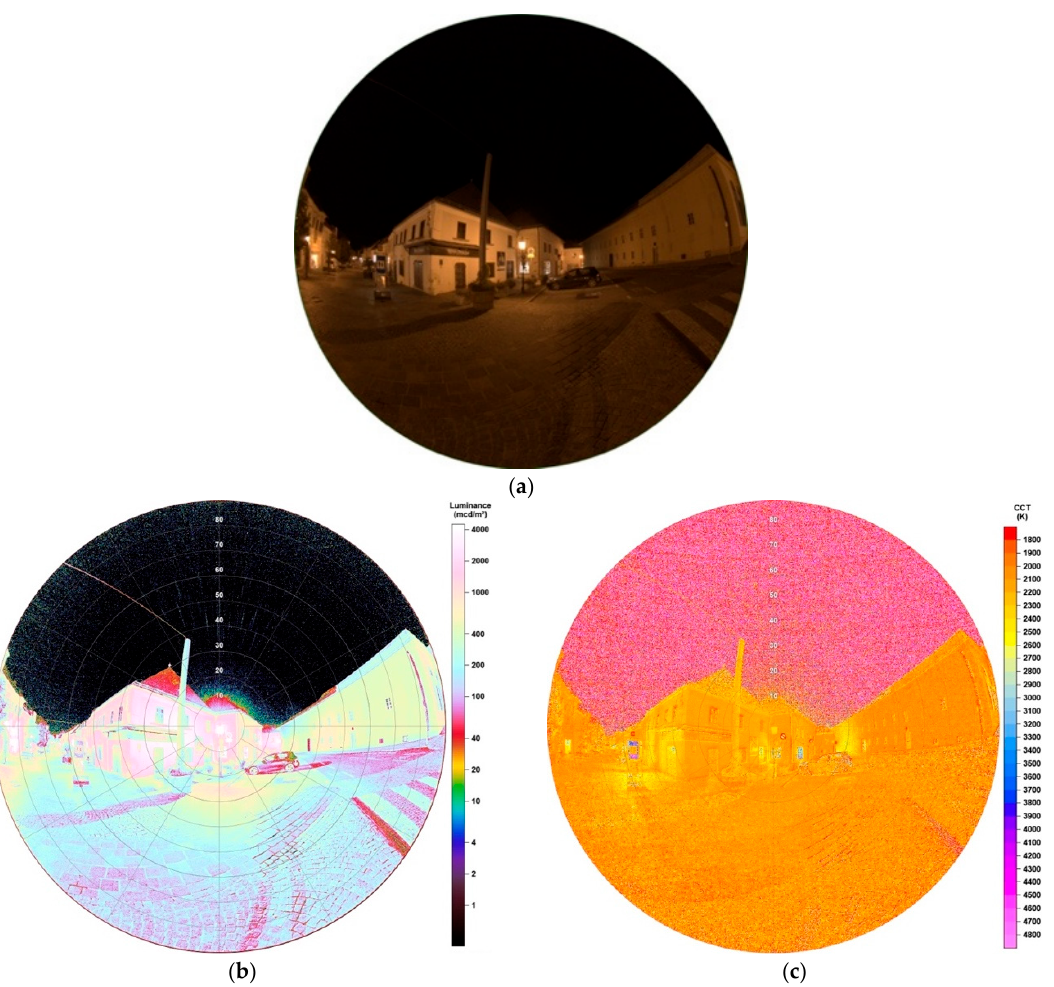
Figure 10. ( a ) Image of lantern during night-time taken with fisheye lens for detailed analysis (date: 29.07.2019, 23:29 h; exposure time: 0.1 s); ( b ) Luminance matrix of image (a) as displayed by SQC; ( c ) CCT matrix of image (a) as displayed by SQC.